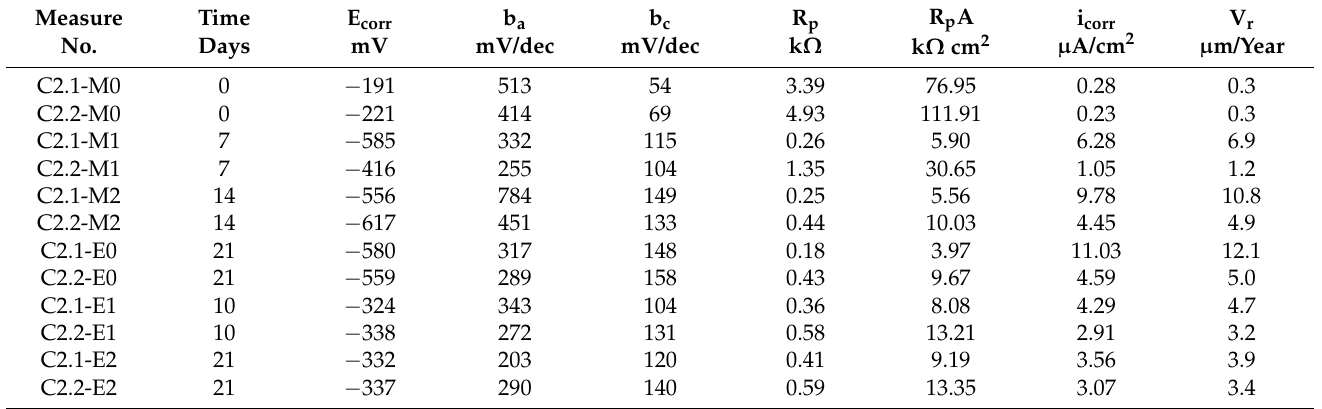
Table A2. Comparison of results from analyzing polarization curves obtained for two selected specimens C2.1 and C2.2 and measuring before (M0) and after 7 (M1) and 14 (M2) and 21 (E0) days chloride migration and after 10 (E1) and after 11 (E2) days chloride